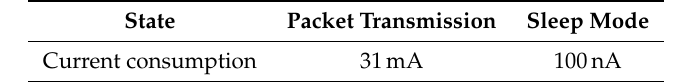
Table 3. Current consumption of SX1272 for packet transmission and sleep mode for transmit power